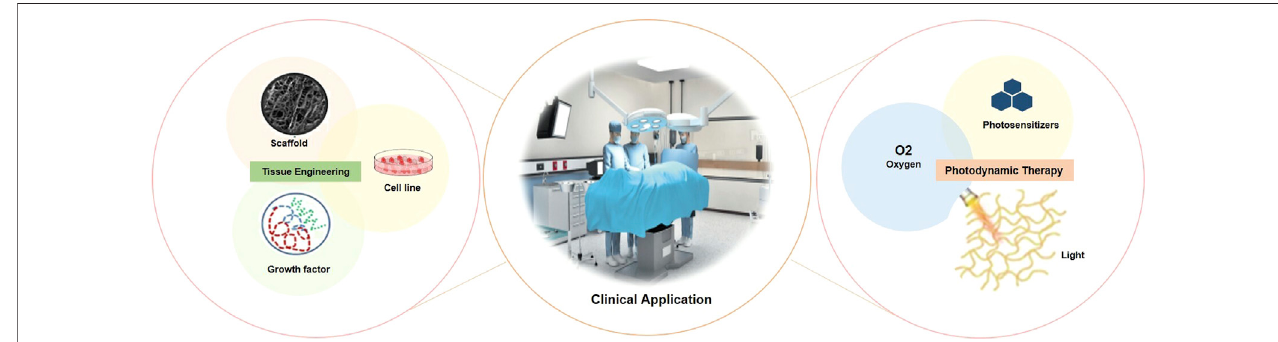
FIGURE 1 | Main factors involved in the development of Tissue Engineering and PDT for clinical application. The cells that will be cultured are selected, along with the biomaterial to be used for the development of the scaffold, followed by the insertion of regulatory signals, such as growth factors. Photodynamic Therapy (PDT) is based on the combination of the photosensitizer (PS) through monochromatic light at a speci fi c wavelength ( λ ) and molecular oxygen (O 2 ) (Source: Authors own elaboration).